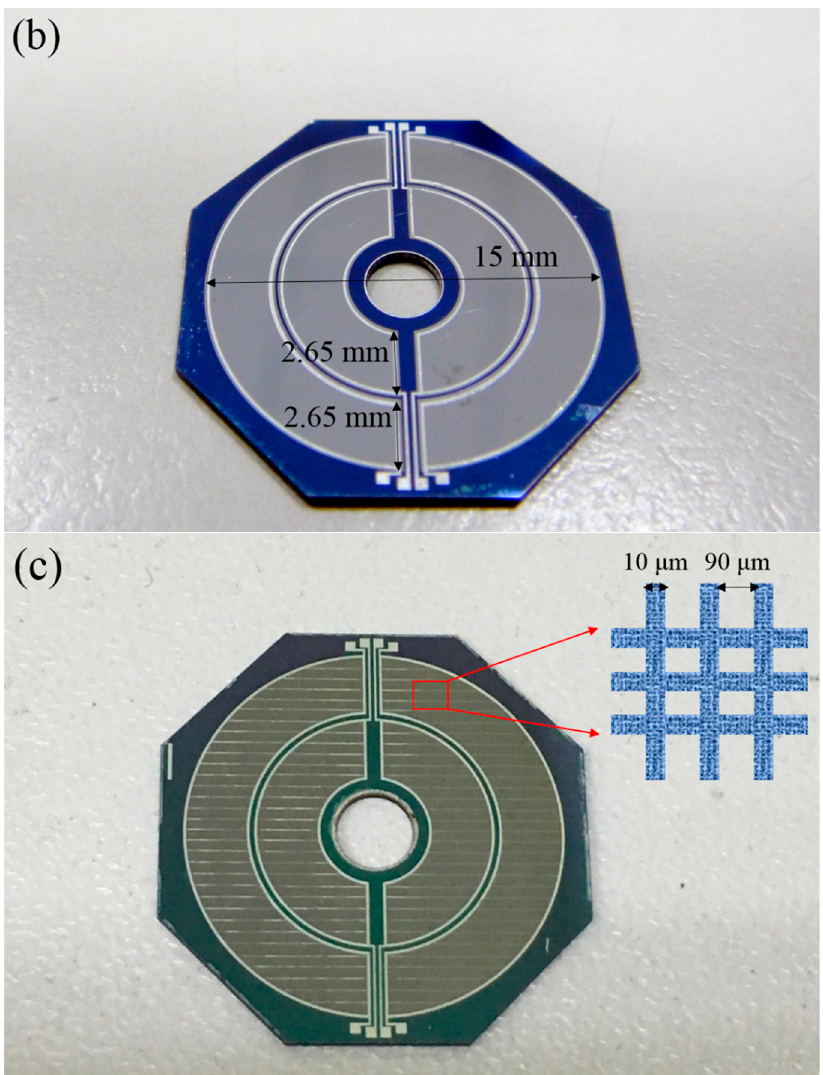
Figure 1. ( a ) The configuration of a commercial (MF) BSE detector with four fan-shaped working areas, ( b ) the configuration of a multi-annular (MA or MA p-n) BSE detector with four semi-ring working areas and ( c ) the configuration of MA-Al BSE detector. The inset shows Al metal grid lines of 10 μ m wide and a spacing of 90 μ m.